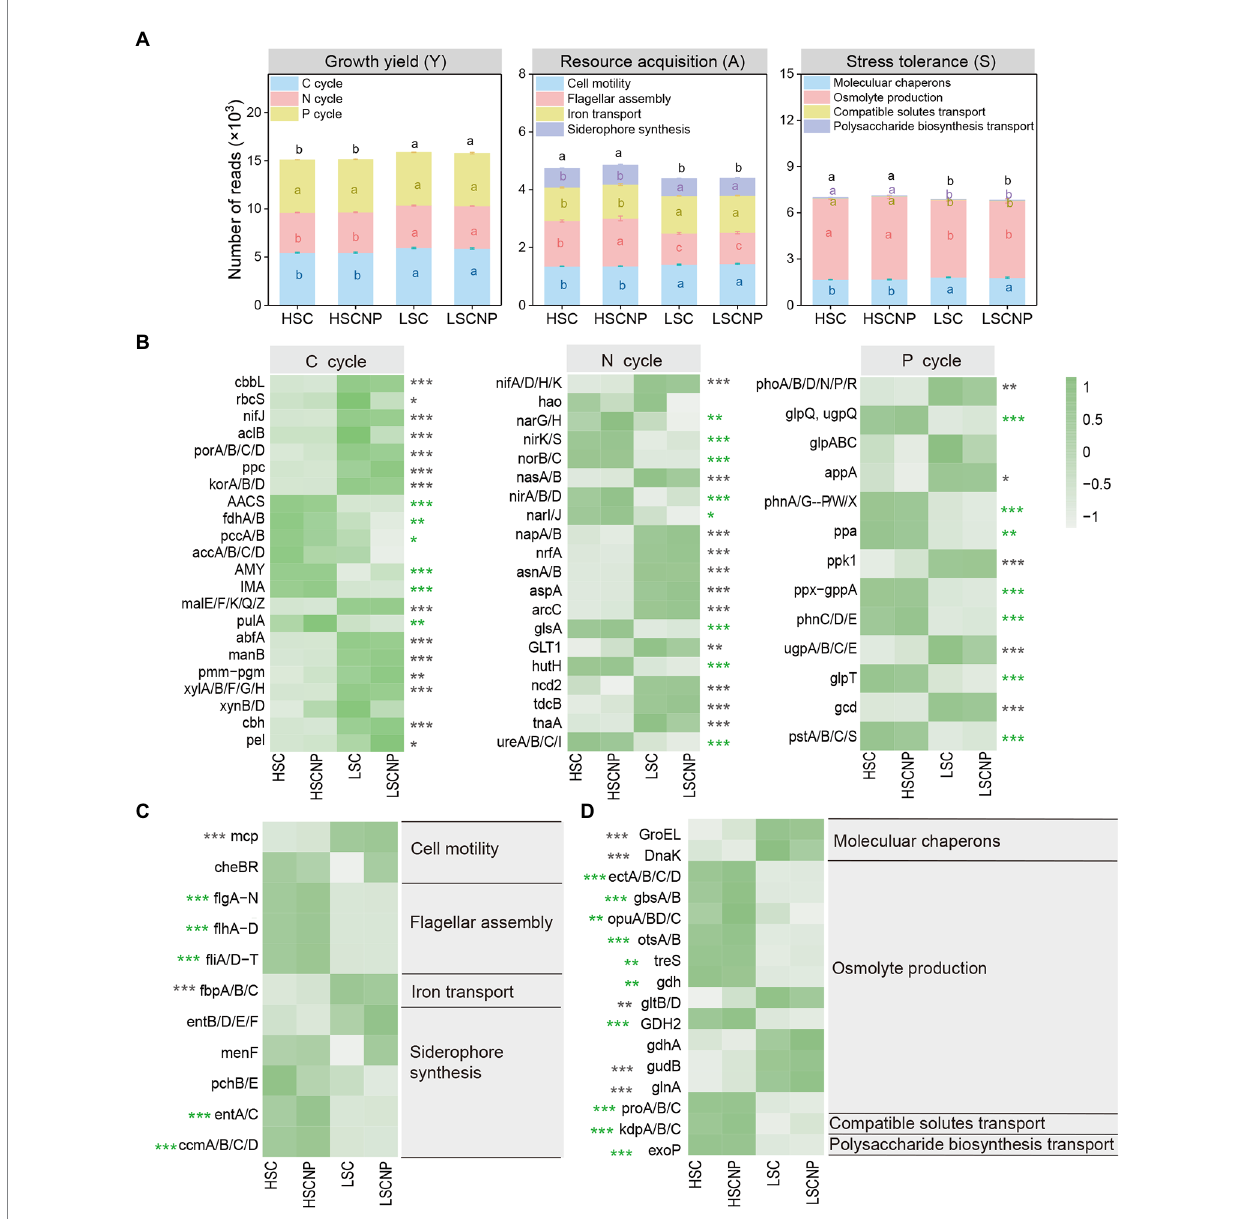
FIGURE 4 The normalized read numbers of genes assigned to growth yield (Y-strategy), resource acquisition (A-strategy), and stress tolerance (S-strategy) (A) . The heatmaps showed specific genes that corresponded to the Y-strategy (B) , A-strategy (C) , and S-strategy (D) , respectively. Green asterisks indicate a higher abundance of genes in high-salinity soil, whereas gray asterisks indicate a higher abundance of genes in low-salinity soil. To ensure that the heatmap was clear and concise, genes of the same gene cluster were combined and displayed together. More details are shown in Supplementary Data S1. Different letters indicate significant differences ( p < 0.05). * p < 0.05, ** p < 0.01, *** p < 0.001. HSC, high-salinity soil added with 13 C-glucose; HSCNP, high-salinity soil added with 13 C-glucose and NP nutrients; LSC, low-salinity soil added with 13 C-glucose; LSCNP low-salinity soil added with 13 C-glucose and NP